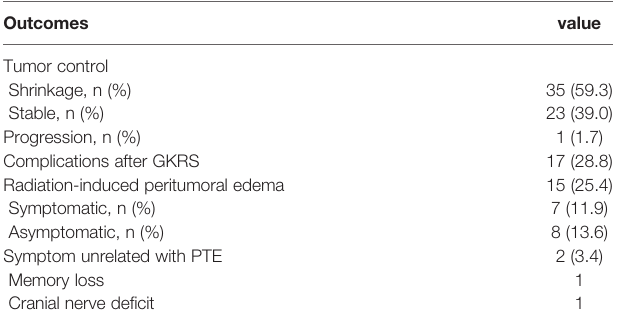
TABLE 2 | Outcomes of 59 patients with 59 asymptomatic meningiomas after initial GKRS. Outcomes value Tumor control Shrinkage, n (%) 35 (59.3) Stable, n (%)